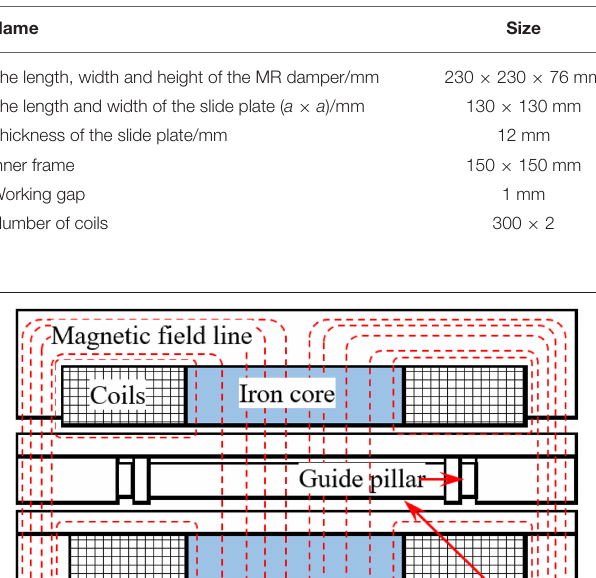
TABLE 1 | The main size of the damper.